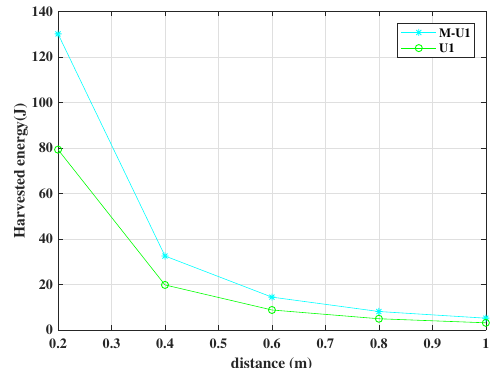
Figure 5. Harvested energy vs. distance for BEEM-NOMA (M-U1) and NOMA (U1) with energy efficiency η ee = 60%. BEEM-NOMA outperforms NOMA.